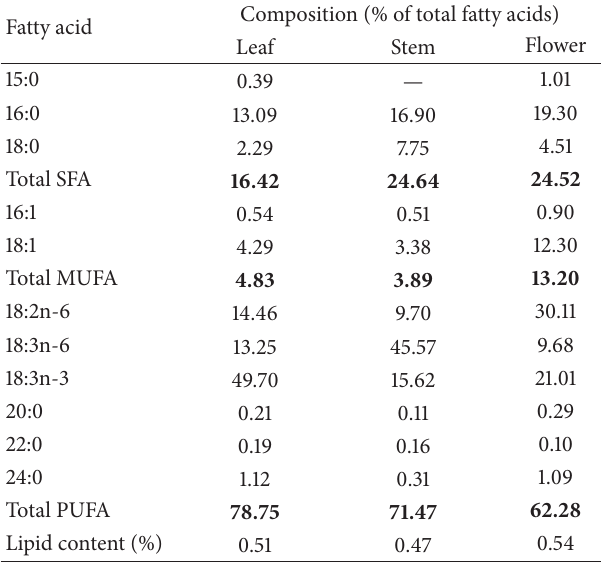
Table 5: Fatty acid composition of purslane